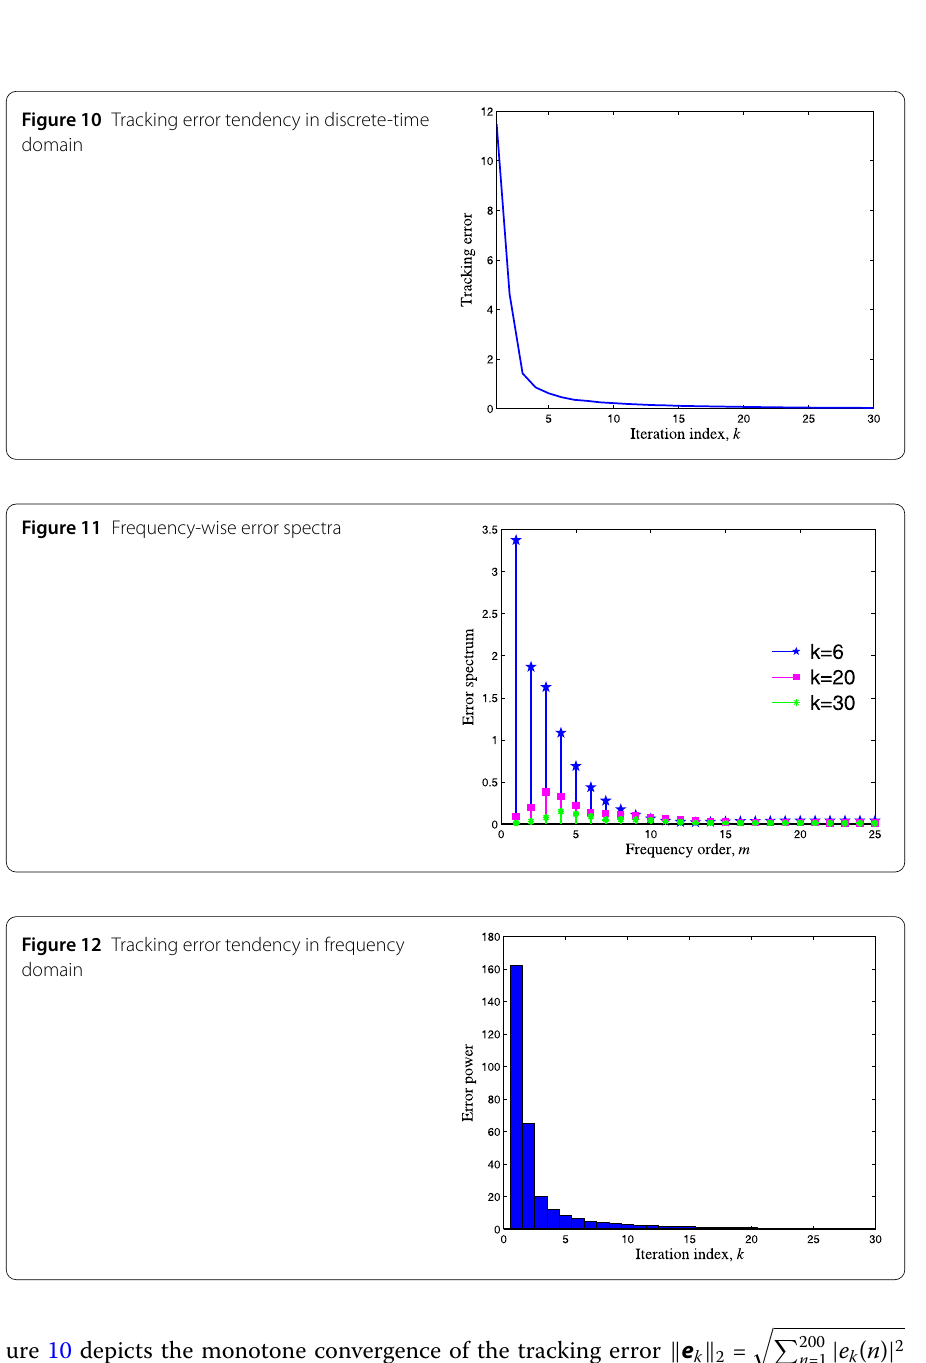
Figure 12 Tracking error tendency in frequency